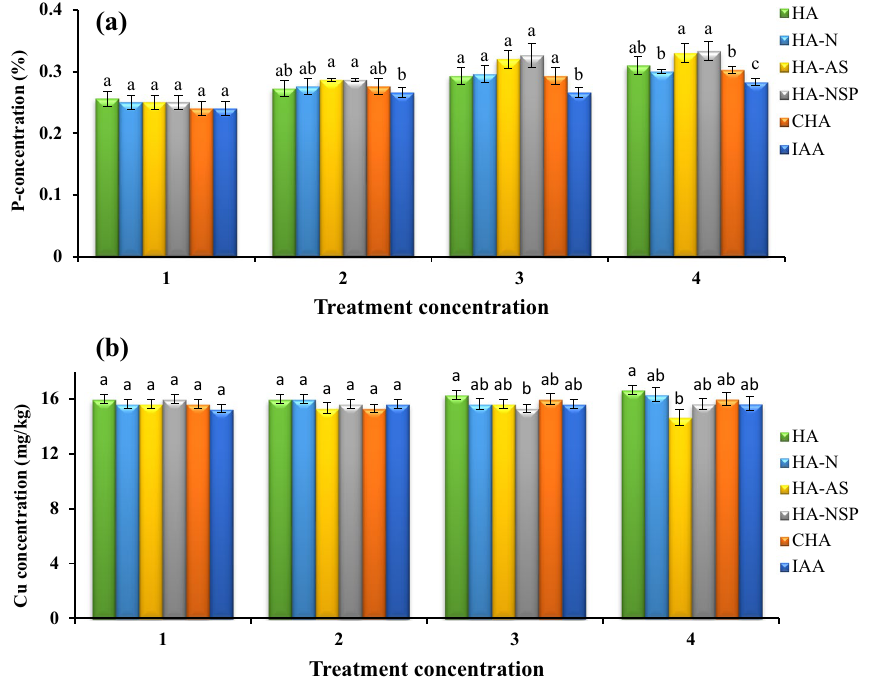
Figure 6. Comparison of average foliar application of experimental treatments on P ( a ) and Cu-concentrations ( b ) at treatment concentrations (levels 1, 2, 3 and 4 for HA, HA-N, HA-AS, HA-NSP and CHA treatments of 0, 200, 400 and 600 mg L −1 and 0, 10 –6 , 10 –5 and 10 –4 molar IAA). Different letters in each figure show significant difference at p ≤ 0.05 by Duncan multiple range test. HA, HA extracted from vermicompost without enrichment; HA-N, HA extracted from vermicompost enriched with 1% nitrogen; HA-NSP, HA extracted from vermicompost enriched with 1% nitrogen, 1% sulfur, and 1% phosphorus; HA-AS, HA extracted from vermicompost enriched with Azotobacter chroococcum (21Az) + Pseudomonas fluorescens (Ps 59); CHA, Commercial humic acid; IAA, Indole-3-acetic acid